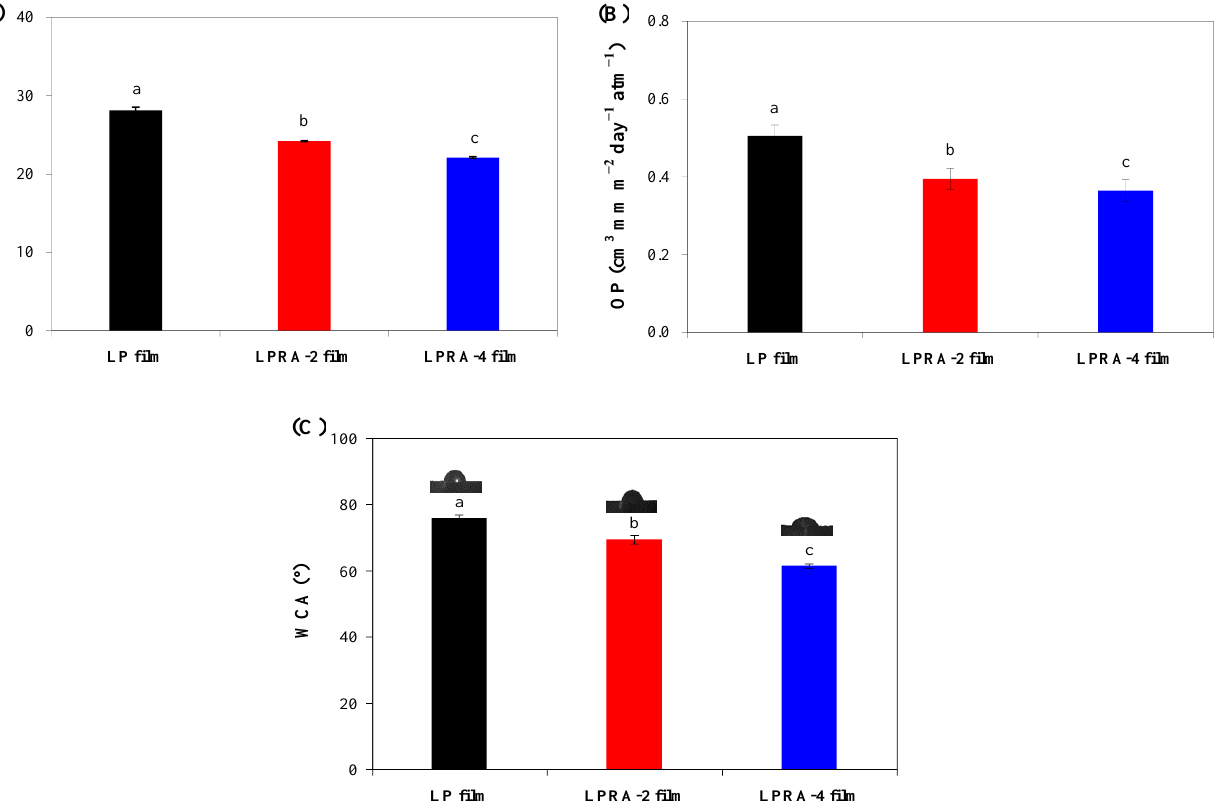
Figure 4. WVP ( A ), OP ( B ) and WCA ( C ) of LP film, LPRA-2 film, and LPRA-4 film. Values are given as mean ± standard deviation (n = 3 for WVP, OP, and WCA). Different lower case letters indicate the statistically significant difference ( p < 0.05) within different films.